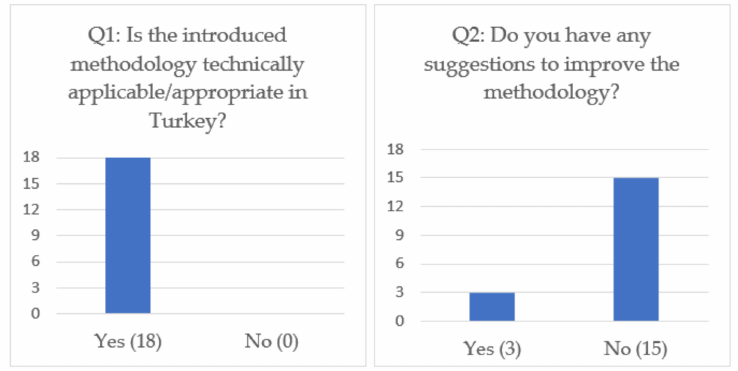
Figure 15. Interview results.